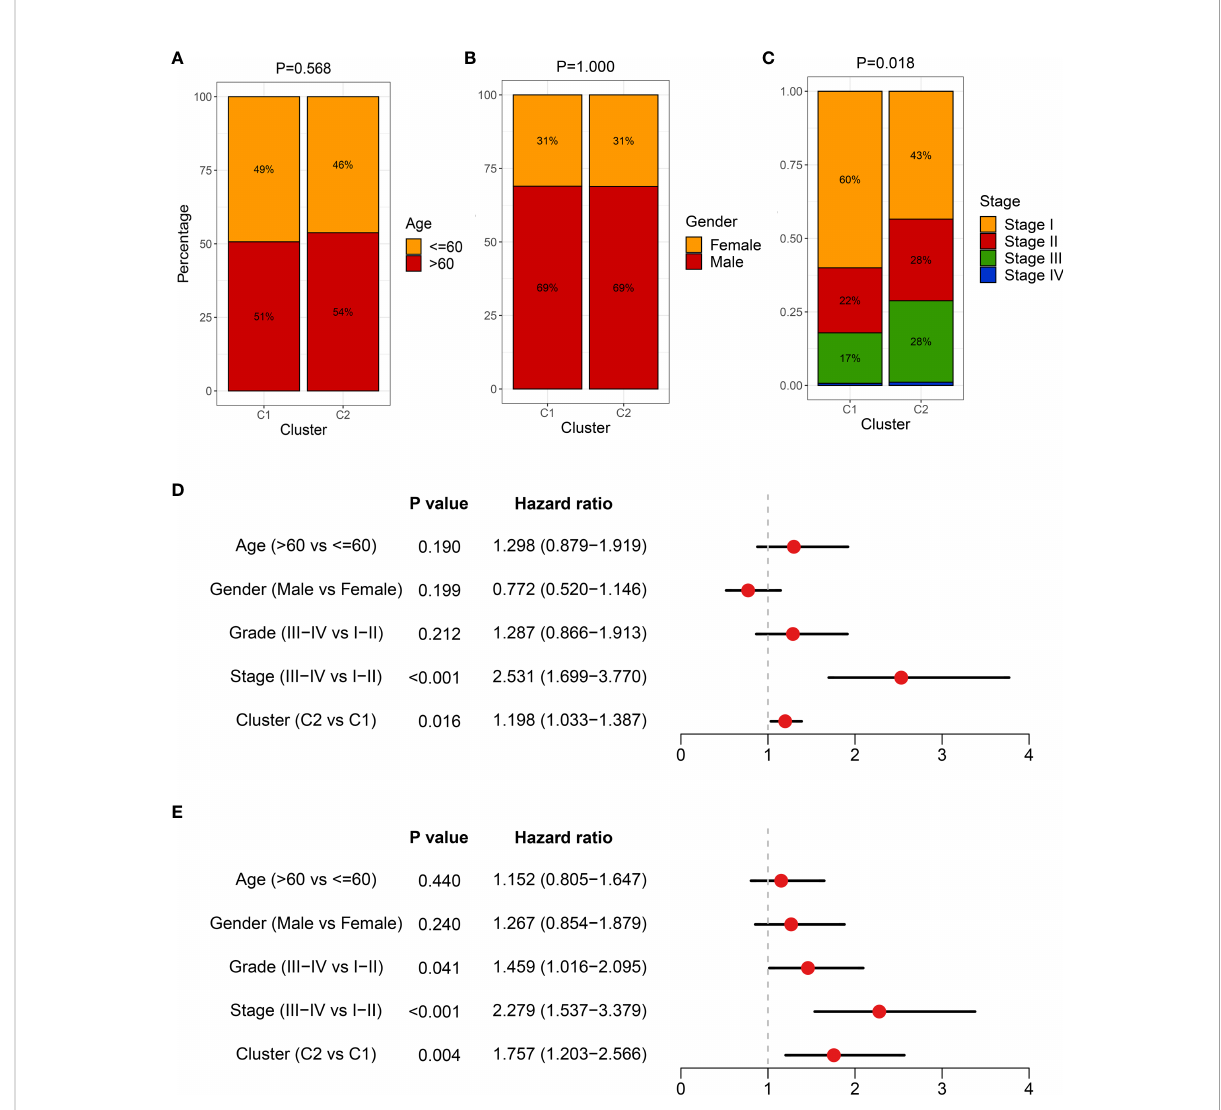
FIGURE 8 The clinical characteristics of heterogeneous necroptosis subtypes. (A – C) Composition percentage of clinical characteristics, including age (A) , gender (B) , and American Joint Committee on Cancer (AJCC) stage (C) , respectively. (D) Multivariate Cox regression analysis of overall survival (OS) in TCGA-LIHC dataset. (E) Multivariate Cox regression analysis of recurrence-free survival (RFS) in TCGA-LIHC